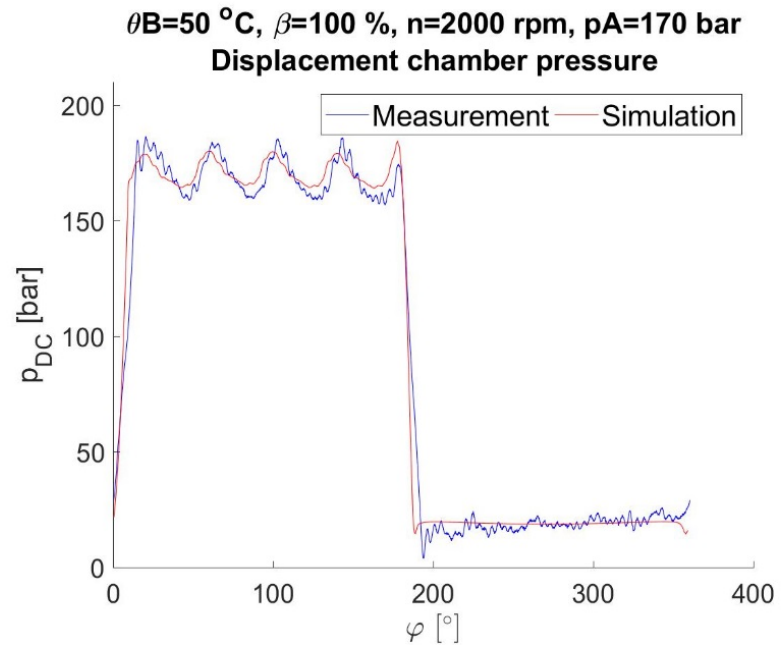
Figure 11. Prediction vs. measurement; displacement chamber pressure.